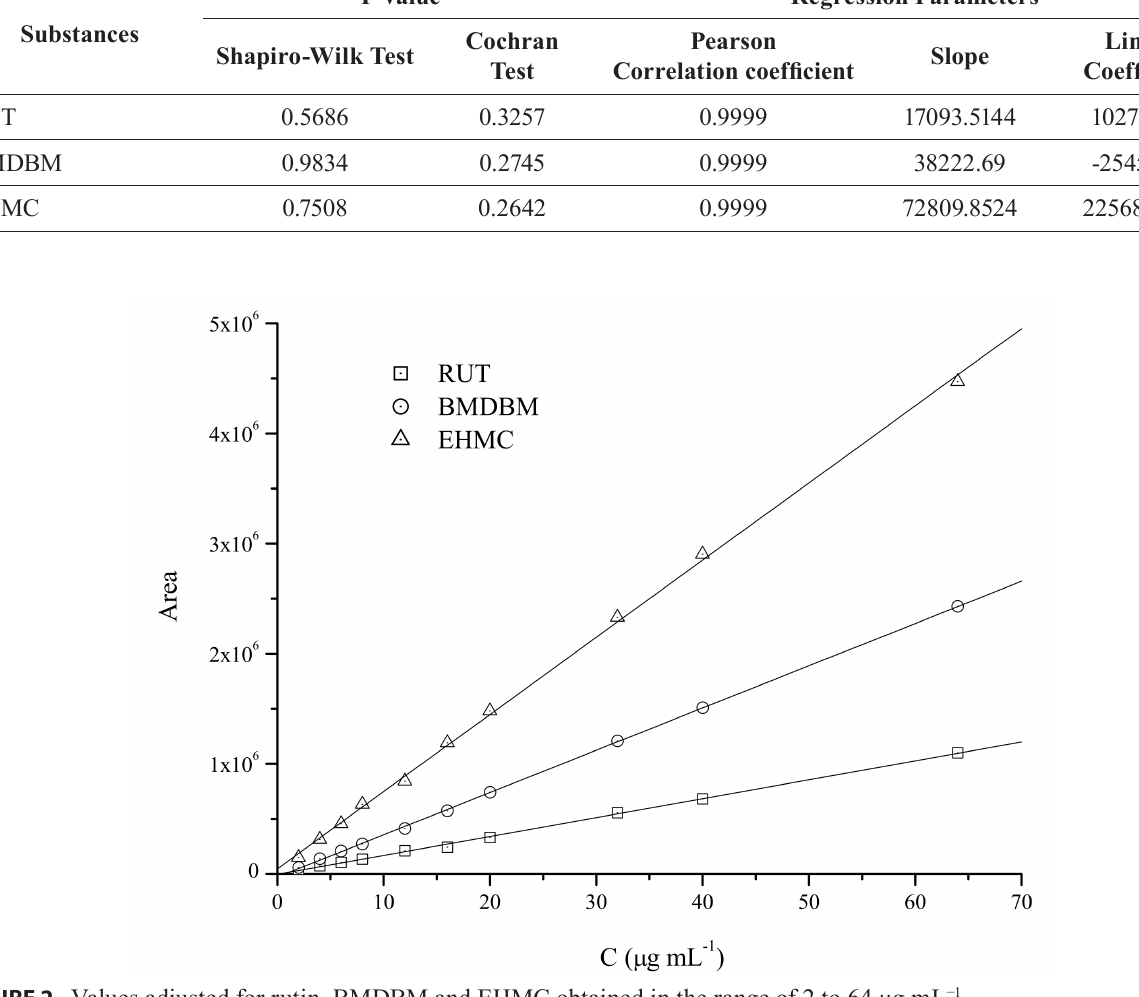
FIGURE 2 - Values adjusted for rutin, BMDBM and EHMC obtained in the range of 2 to 64 μg mL −1